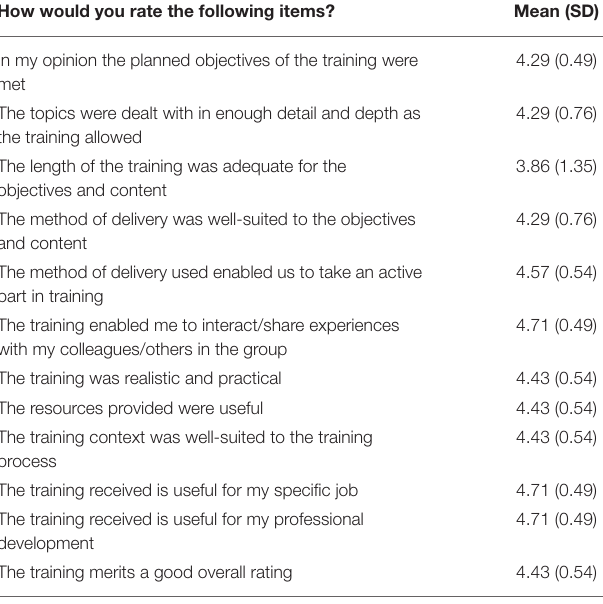
TABLE 2 | The mean and standard deviation for staff satisfaction with the 3-day training program.